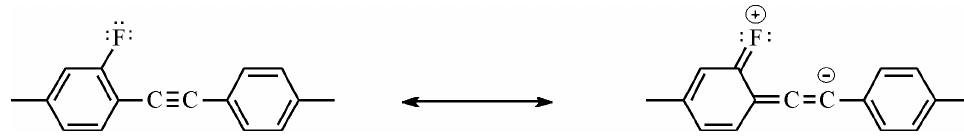
anisotropy, birefringence, elastic constants, viscosity and clearing point, as described in Figure 8. Figure 8. Functionalization of molecules by introducing a polar group: F or Cl, CN, NCS, CF , OCF in the terminal position (Δ ε > 0). The direction of observed changes of properties 3 3 is given by inequality signs. Dielectric anisotropy (Δ ε ), birefringence (Δ n ), clearing temperature ( T ), viscosity ( ν or η ) and elastic constants ( k N–I